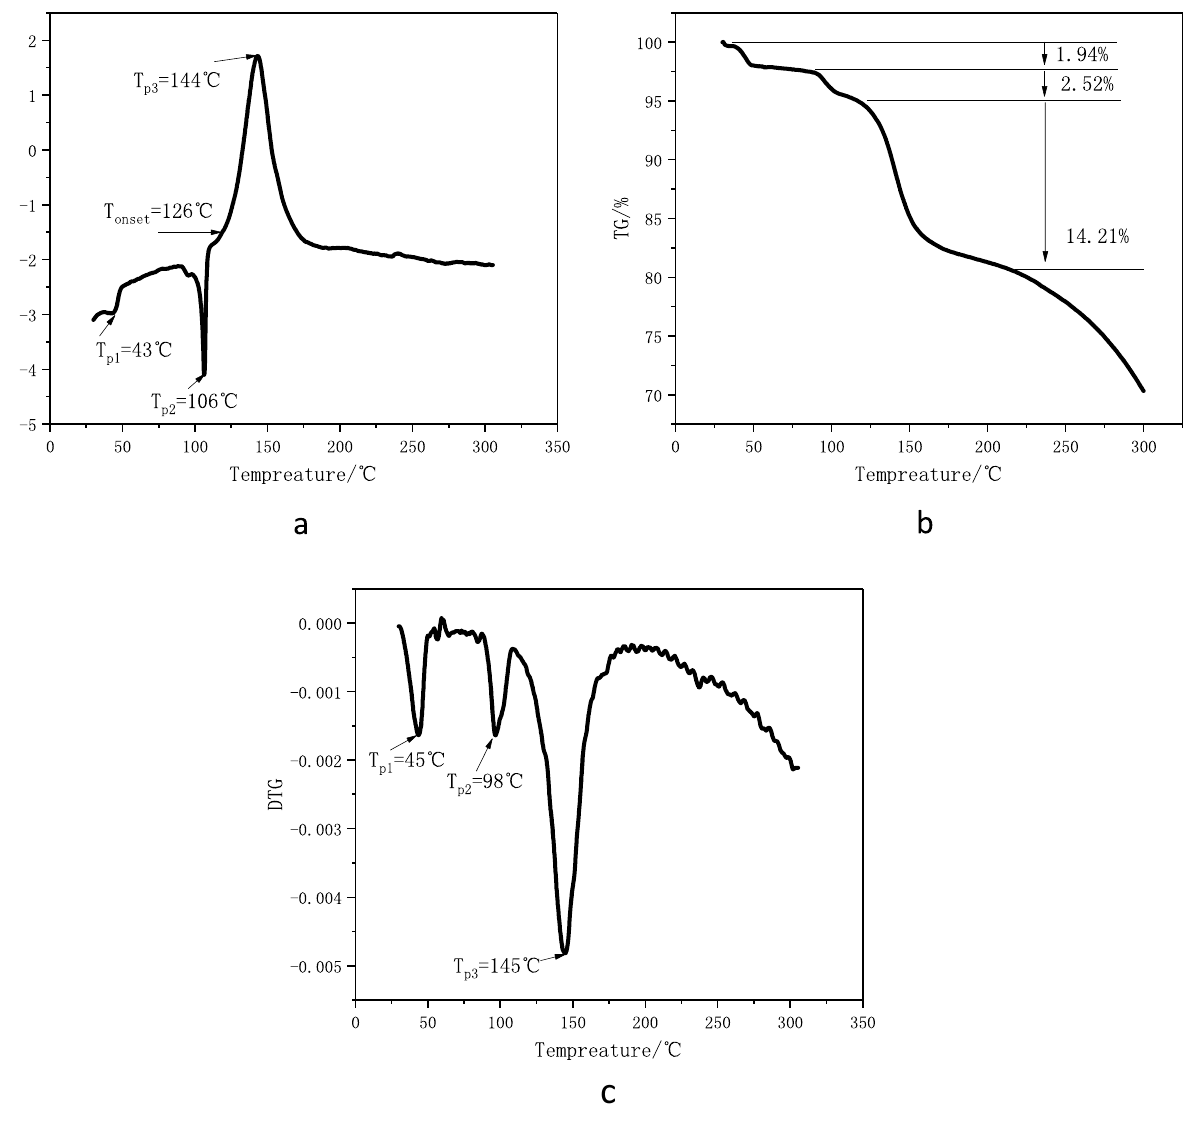
c Figure 1. DSC curve ( a ) 、 TG curve ( b ) and DTG curve ( c ) of 1-nitroso-2-naphthol at 5